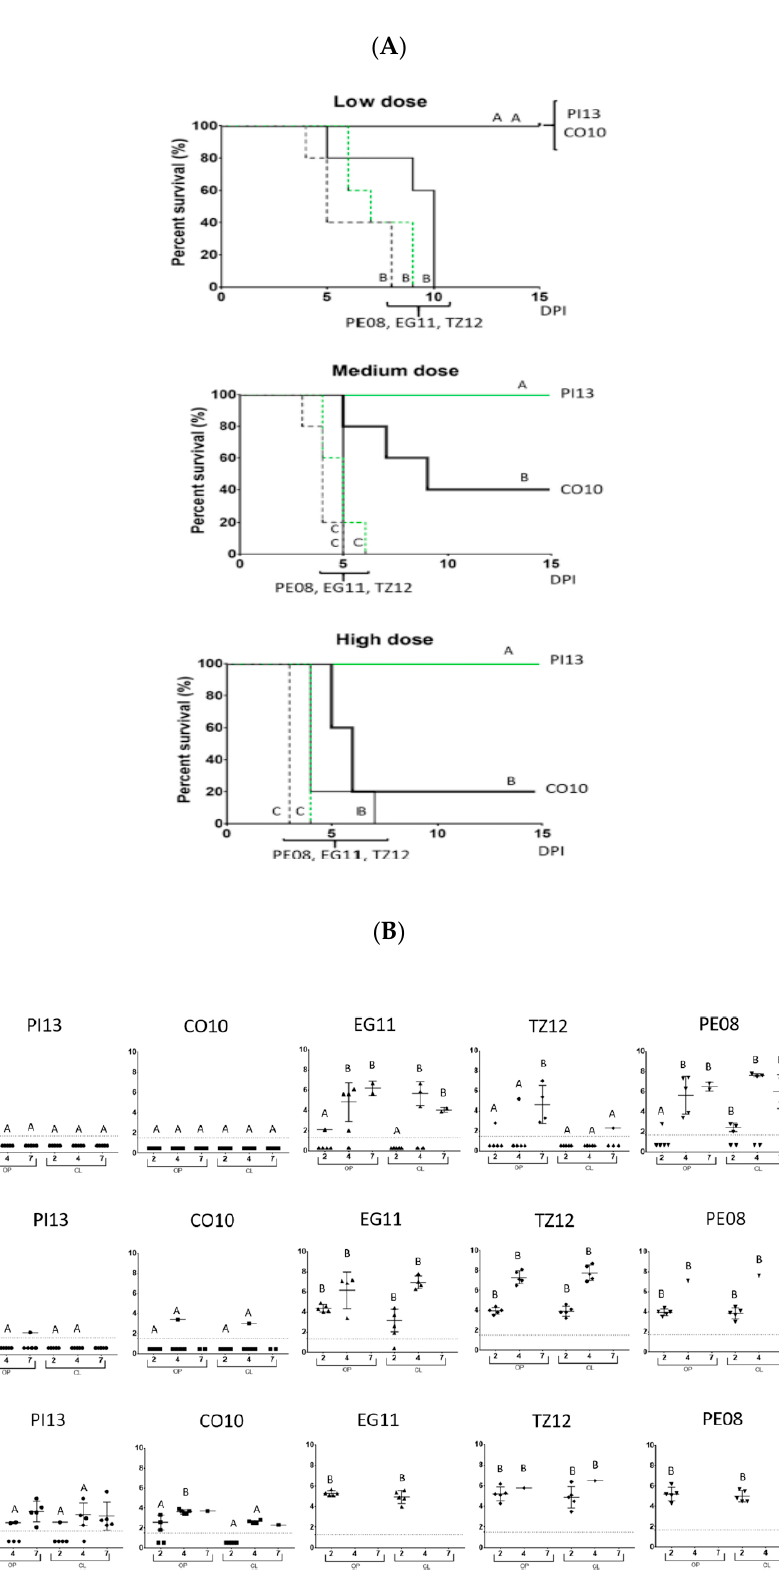
Figure 6. Comparison of the capacity for virulence, replication and shedding between chicken and wild bird isolates. Excerpts from Figures 1 and 3 in Ferreira, H.L.; Taylor, T.L.; Dimitrov, K.M.; Sabra, M.; Afonso, C.L.; Suarez, D.L. Virulent Newcastle disease viruses from the chicken origin are more pathogenic and transmissible to chickens than viruses normally maintained in wild birds [55]. ( A ) Survival curves of directly inoculated birds. Chickens were separated into 3 groups for each virus and inoculated with a low, medium, and high dose of the five NDV strains (PE08, EG11, TZ12, CO10, PI13). Mortality in each experimental group was followed daily over 14 days. No common letters indicate significant